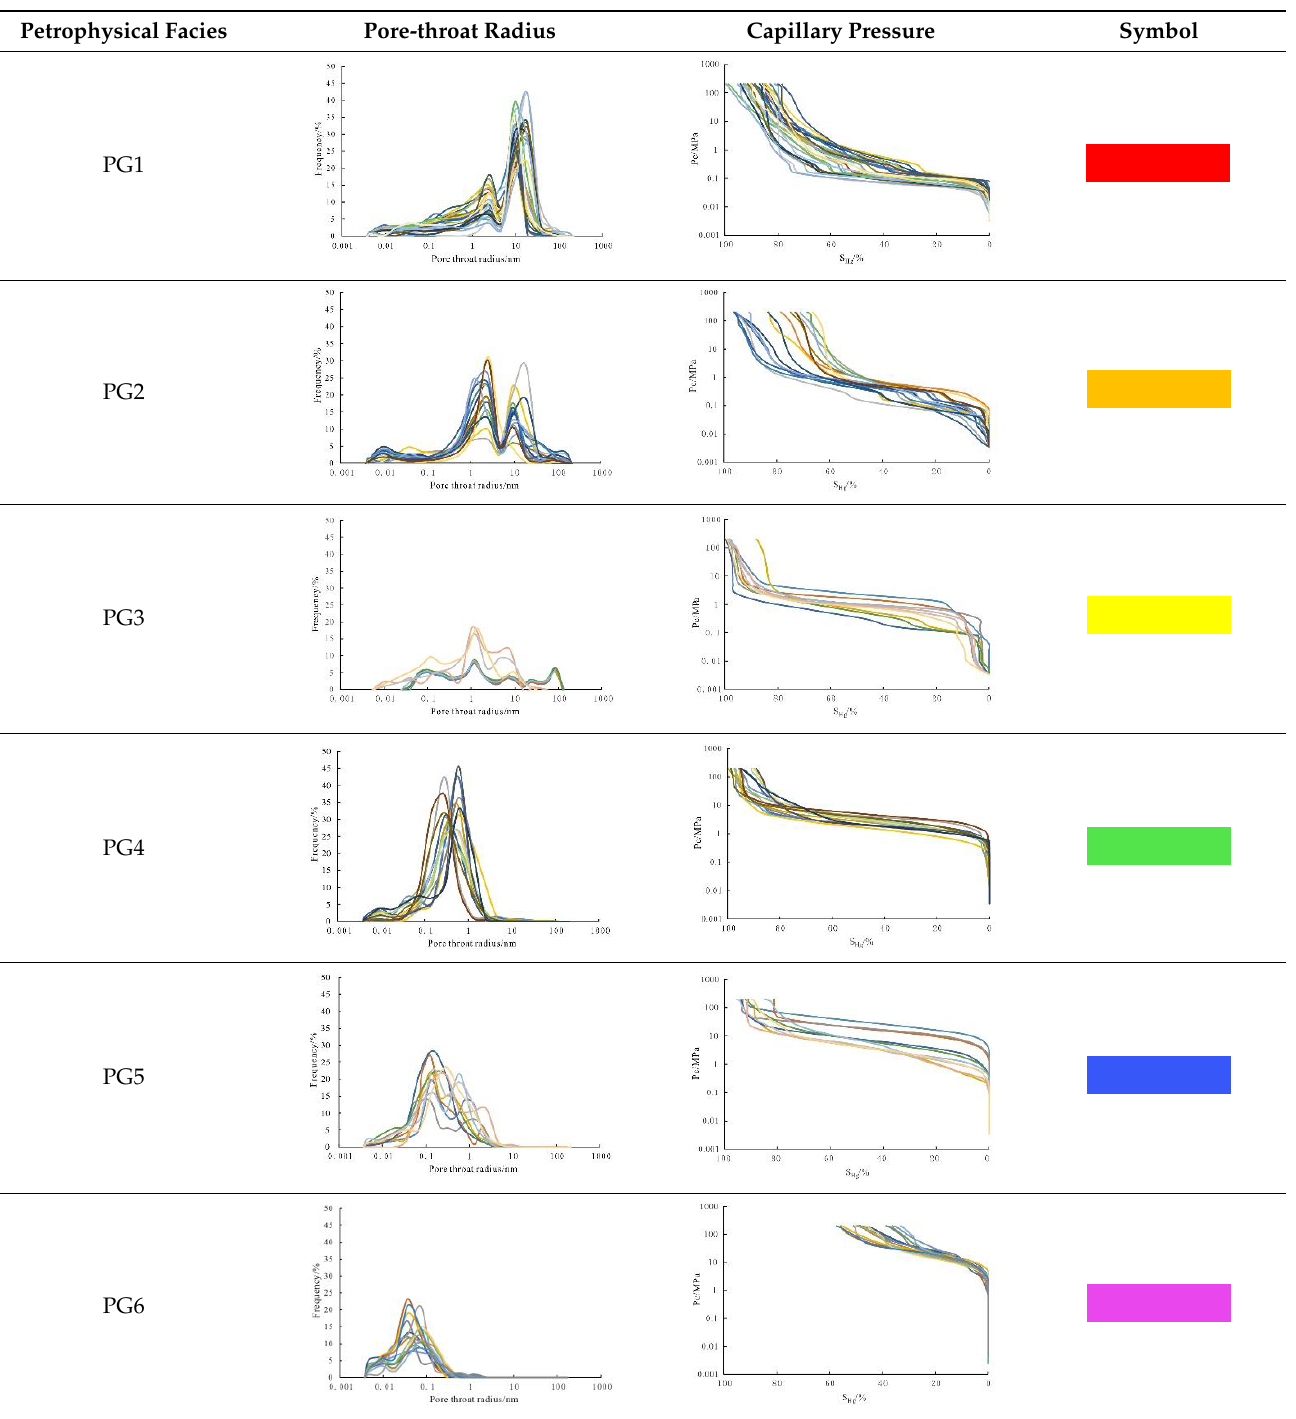
The distribution of PG1 pore-throats is dominated by double peaks of large and weak pore throats. The capillary pressure curve is in the shape of a left concave long platform (Table 1). The porosity is between 13.4 – 36.3%, the permeability is 12.24 – 209 mD, the dis- placement pressure is 0.0035 – 0.398 MPa, and the median pressure is between 0.18 – 16.02